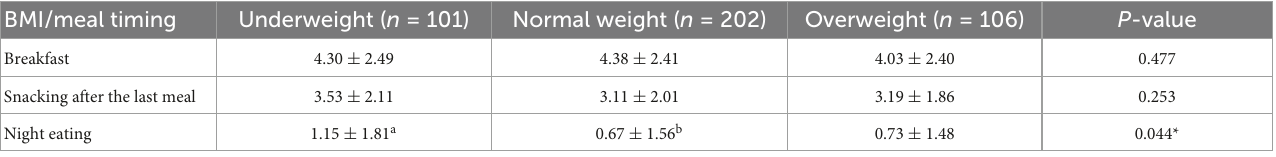
TABLE 2 Mean intake (days per week) of breakfast, snacking after last meal, and eating at night.